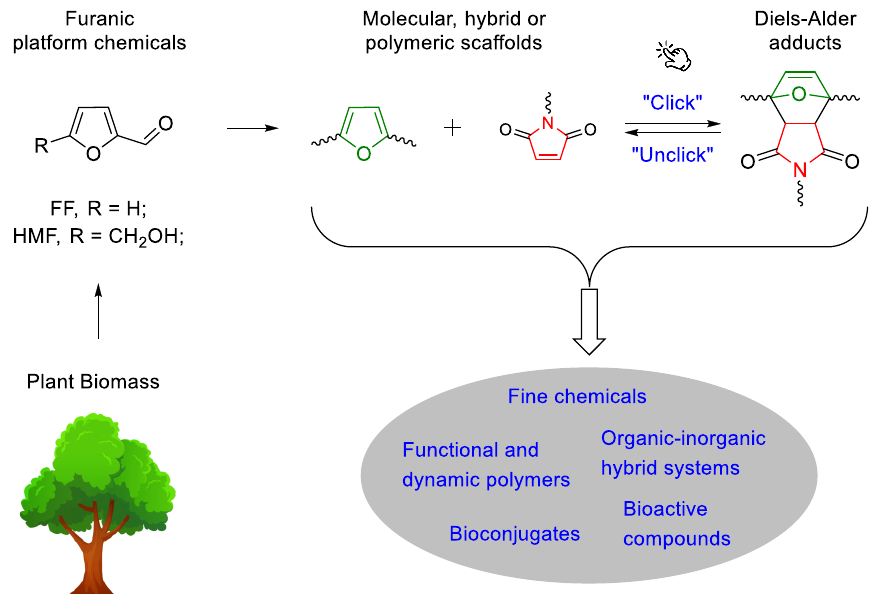
Figure 1. Intermolecular Diels – Alder cycloadditions of biobased furans with maleimides as a sus- tainable «click» approach towards practically important